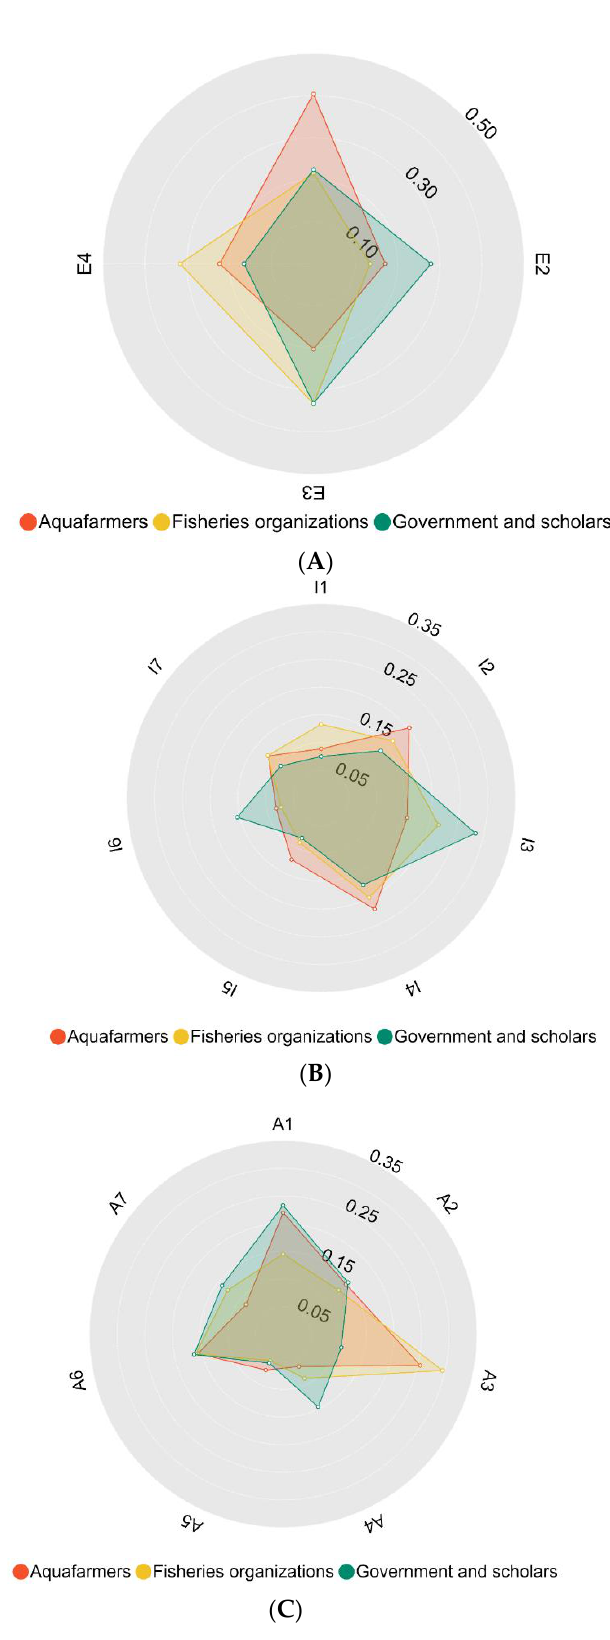
Figure 4. Weight of the key factors among the different perspectives of stakeholders. ( A ) Environment and Climate. ( B ) Industry and Management. ( C ) Adaptation Strategies.